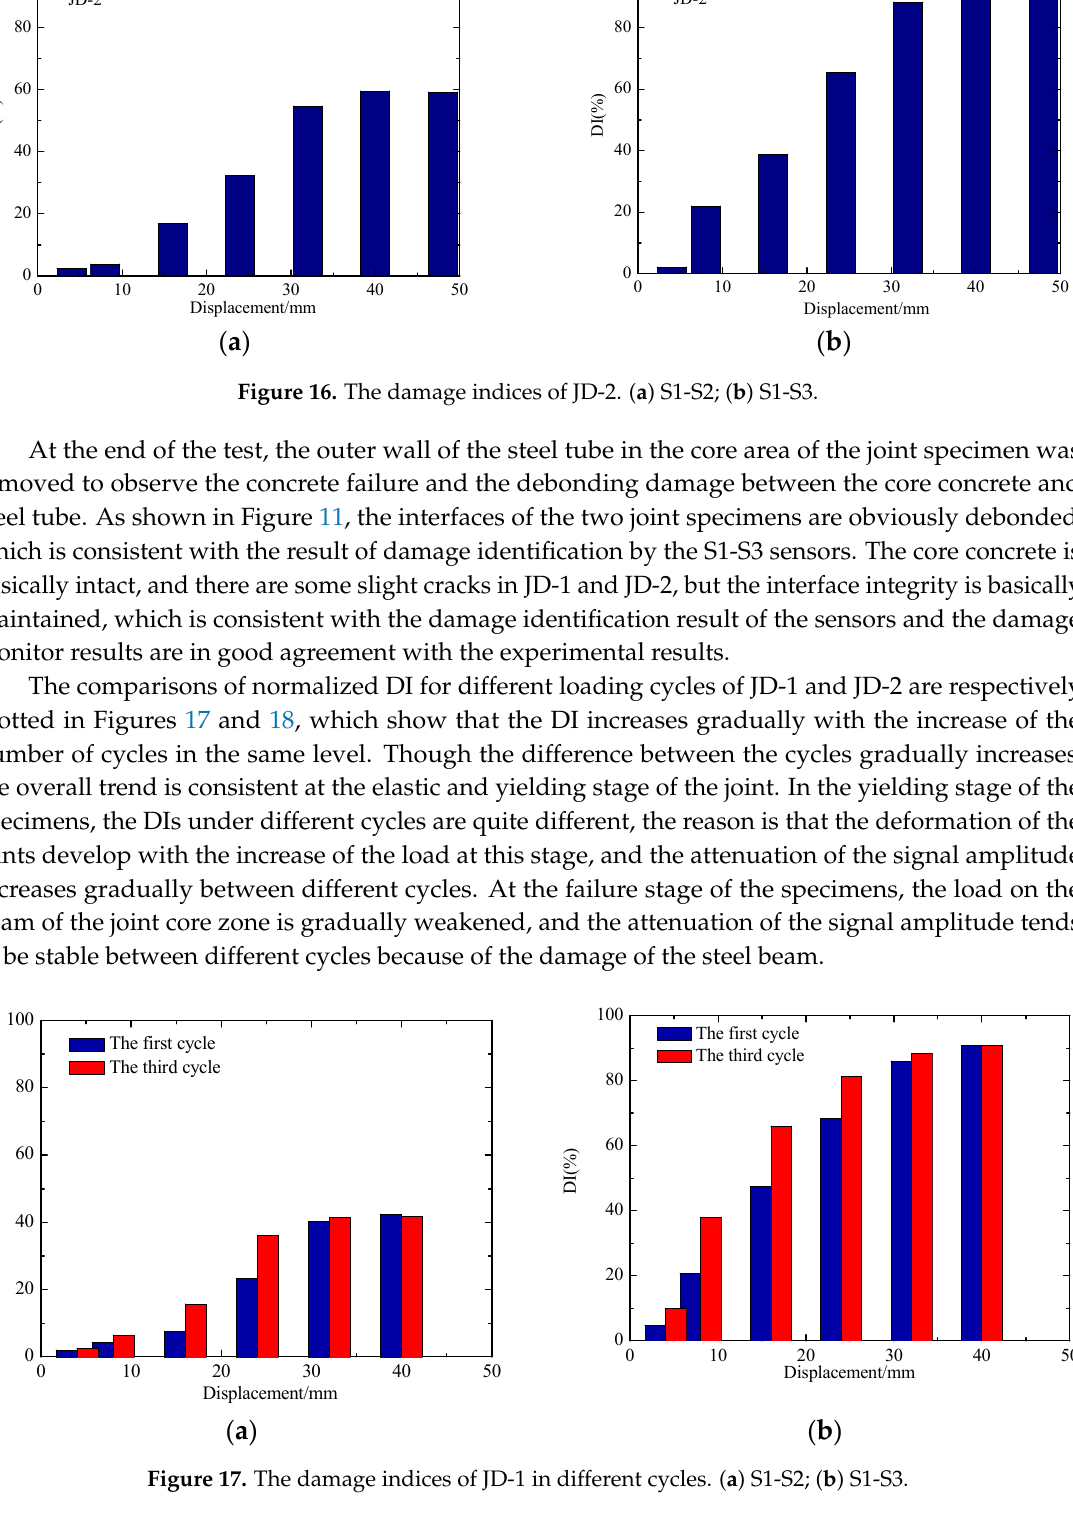
Figure 17. The damage indices of JD-1 in different cycles. ( a ) S1-S2; ( b ) S1-S3.